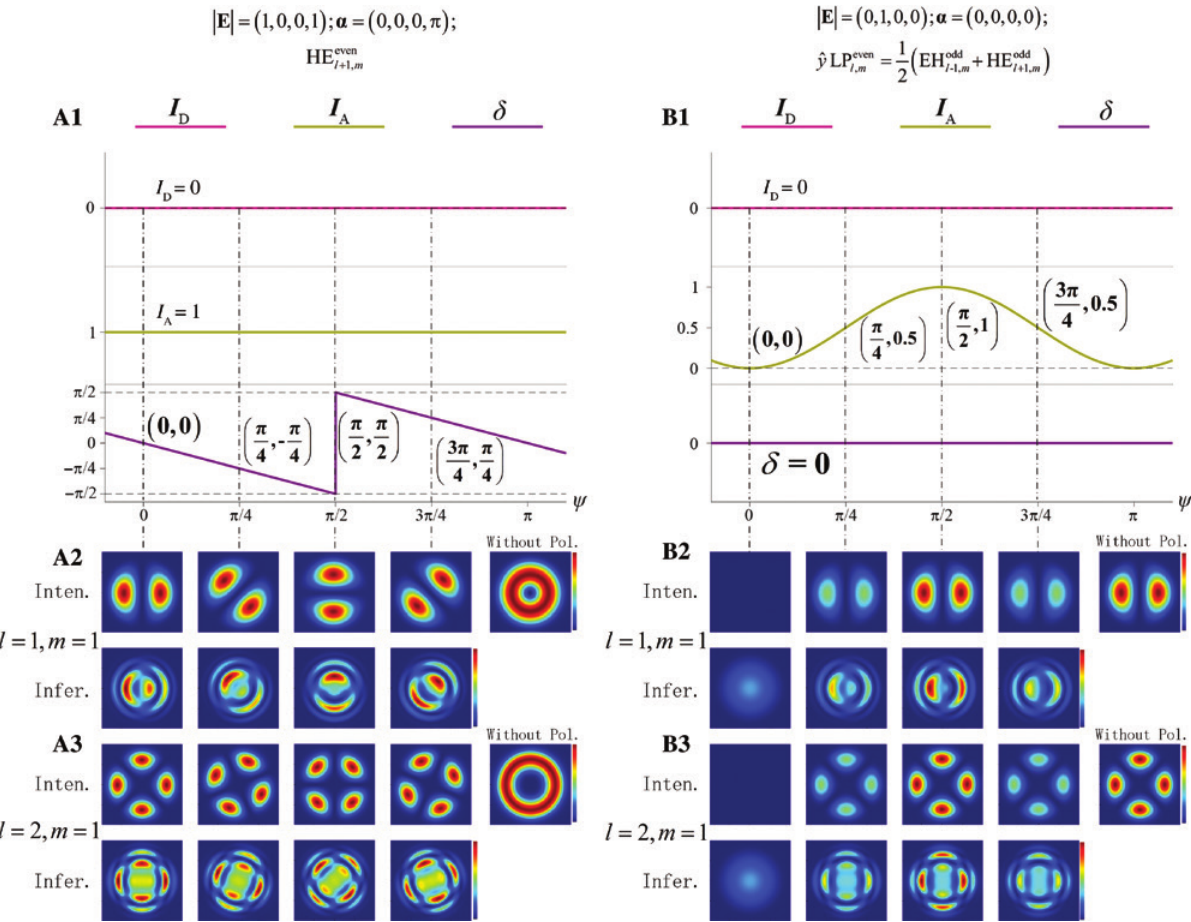
Figure 6: Corresponding relation between the expanded Jones model and mode patterns of a pure CV mode and a pure LP mode. (A) | E | = (1, 0, 0, 1), α = (0, 0, 0, π ) or CV mode bases. (A1, B1) The trend of I (A2, B2) l = 1, m = 1; (A3, B3) l = 2, m = 1. Inten., intensity pattern; Infer., interference